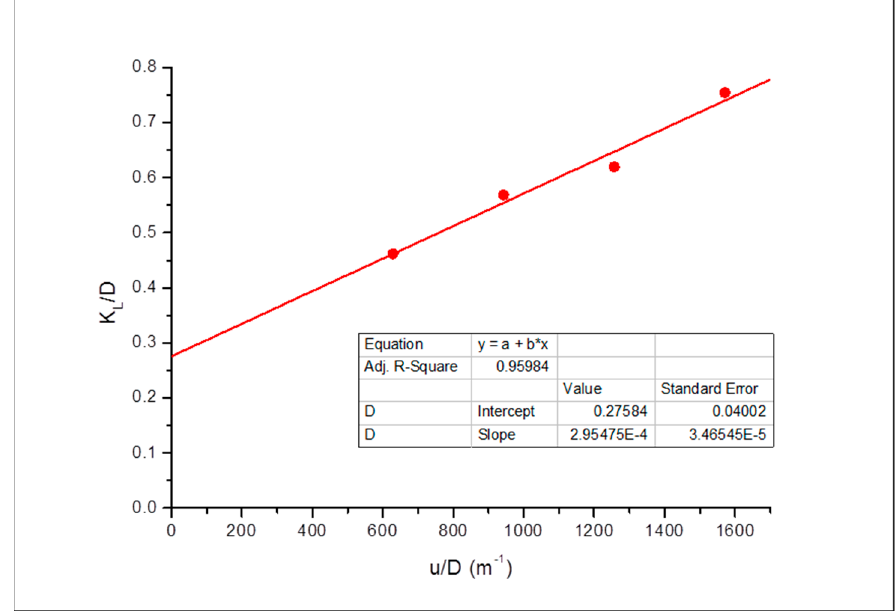
Figure 10. Dispersivity evaluation using the dispersion coefficient and interstitial velocity for Grey Berea (horizontal).